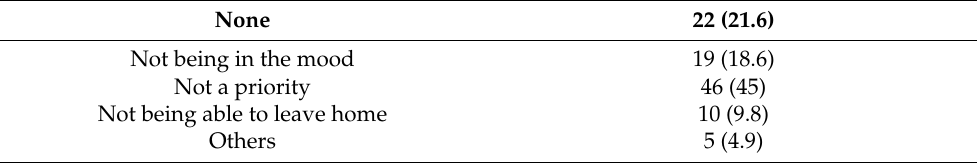
Table 4. Perceived obstacles to exercising during the COVID-19 pandemic